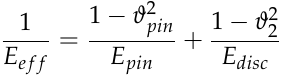
Figure 3. Fabrication of ( a ) pin and ( b ) disc from rail track and wheel material, ( c ) Disc after testing.